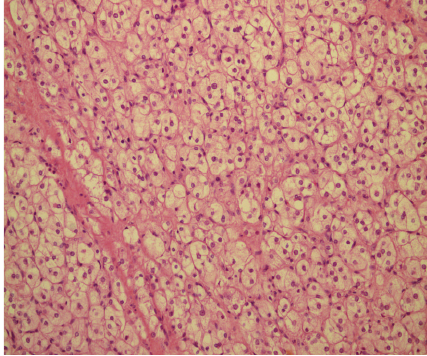
Figure 2: Cells with spongy cytoplasm focally separated by fibrous bands. No mitotic activity was seen.